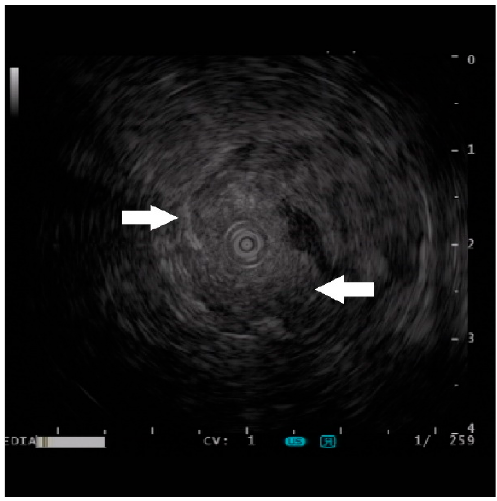
Figure 3. Endoscopic ultrasound image of the lesion (arrows).